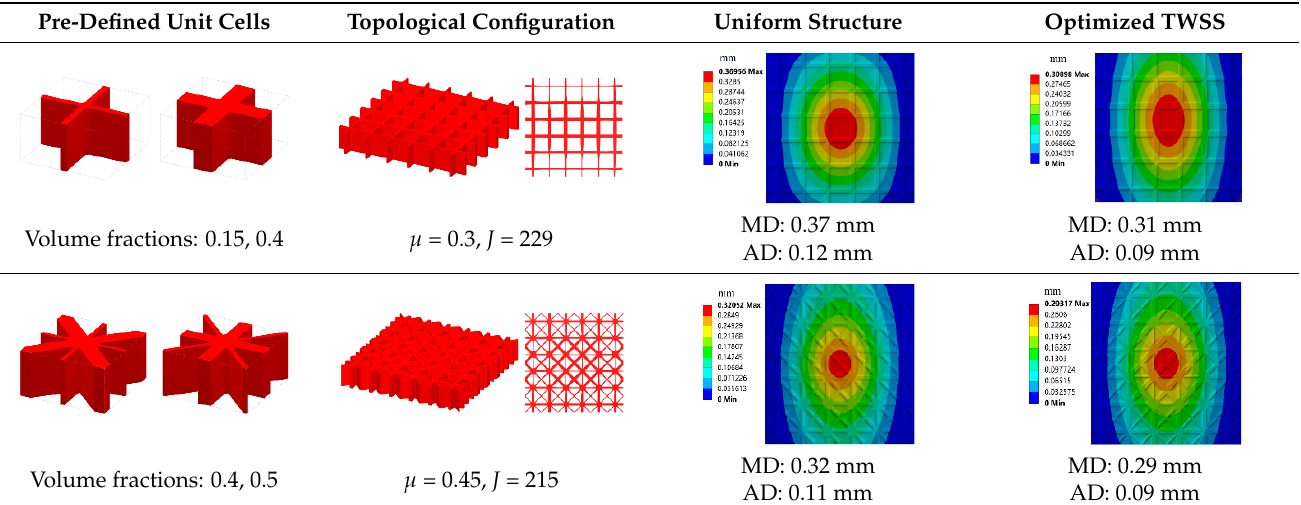
Table 2. Micro-structural and macro-structural topologies and their FEA results.